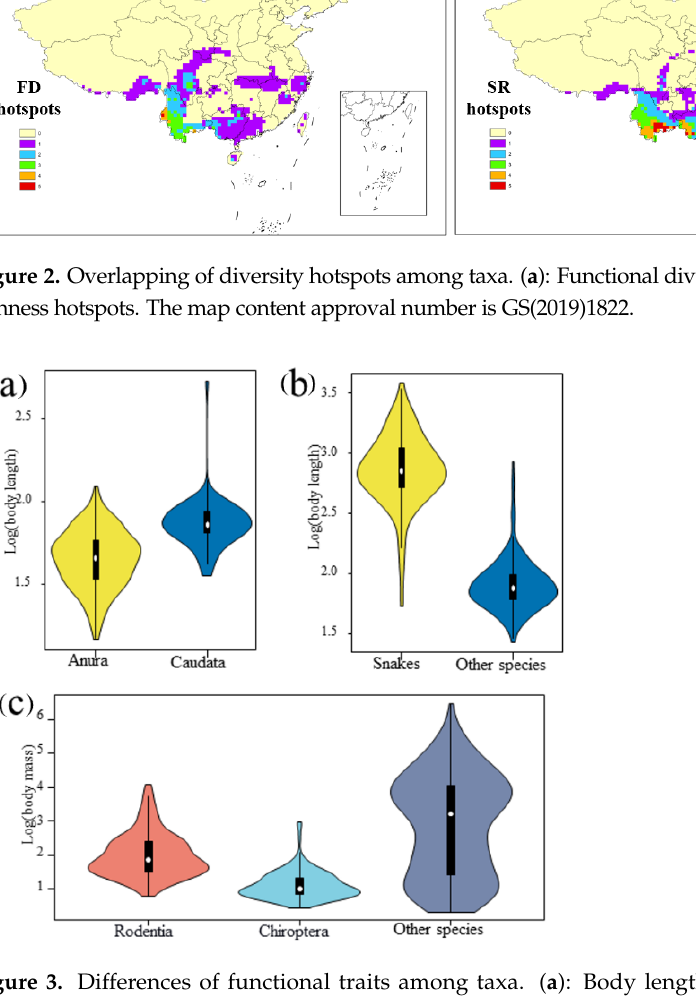
Figure 3. Differences of functional traits among taxa. ( a ): Body length of Anura and Caudata; ( b ): Body length of snakes and lizards. ( c ): Body mass of different groups of mammals.